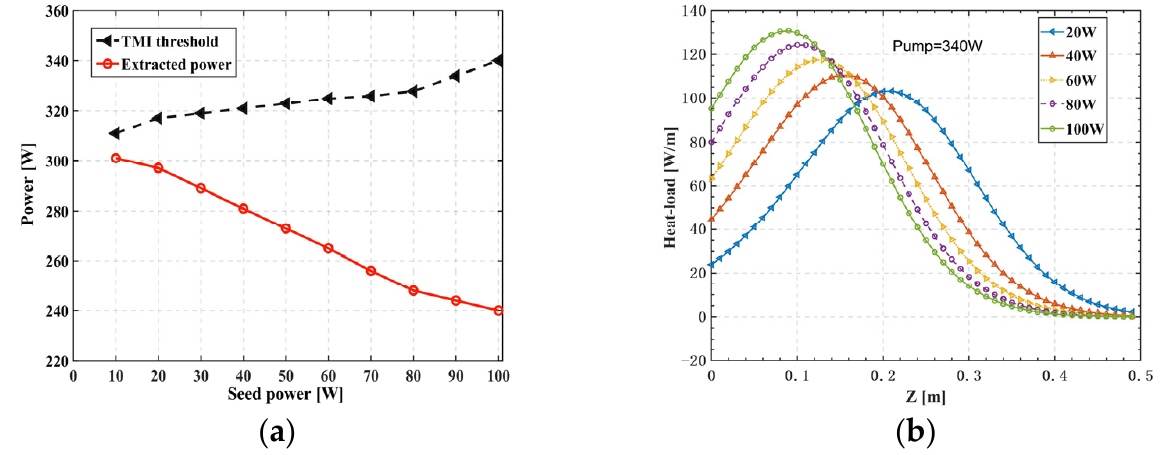
Figure 4. ( a ) Relationship between TMI threshold and seed power of the forward pumped 80/250 µm fiber amplifier, and ( b ) the heat load of fiber amplifiers with different seed power.